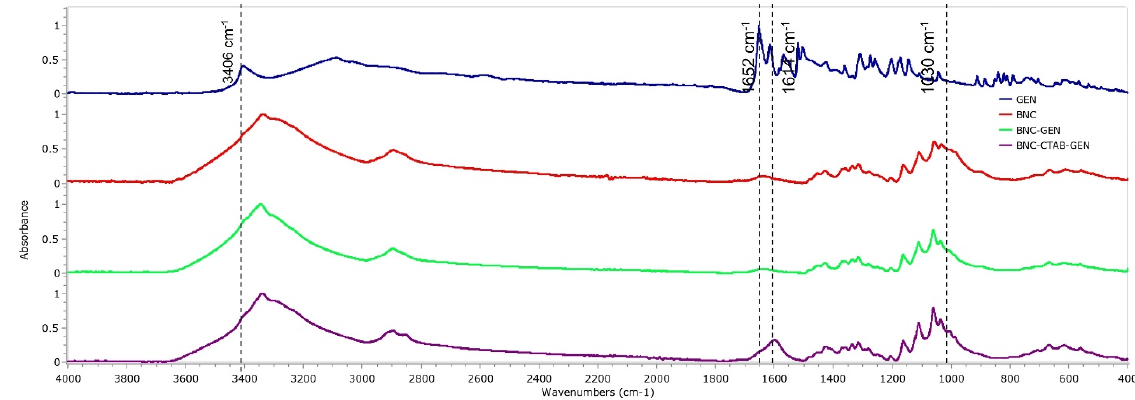
Figure 9. FTIR spectrum of GEN, BNC, BNC-GEN, and BNC-CTAB-GEN.